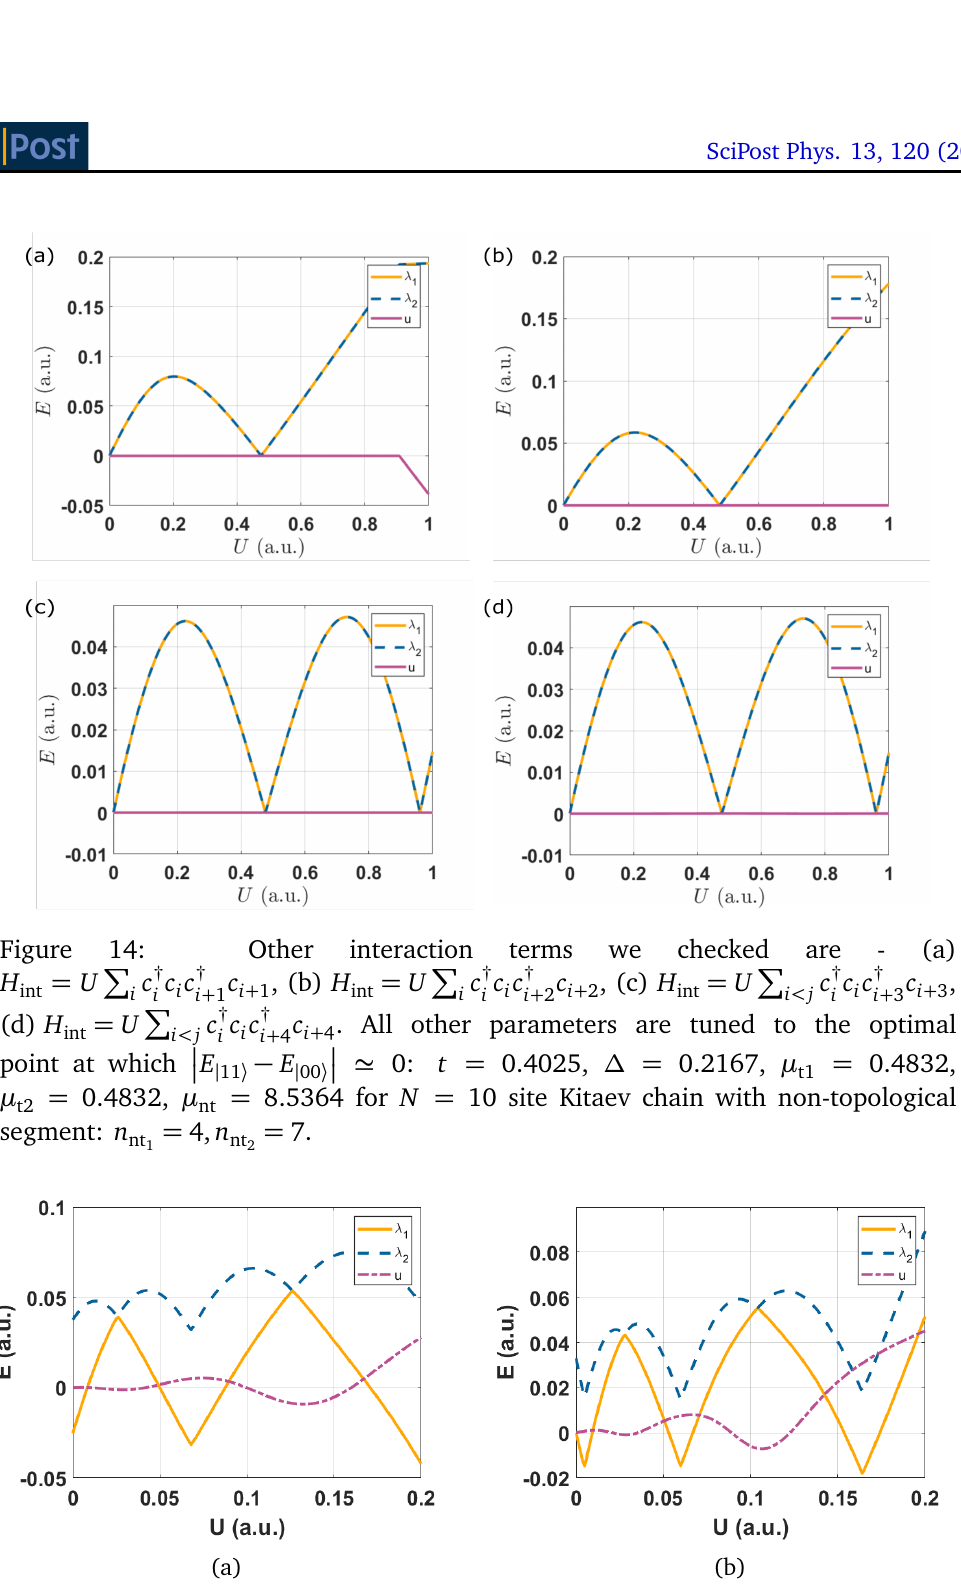
Figure 15: Changing parameters from the optimal point shows that λ (cid:48) s no longer overlap and follow separate trajctories (solid yellow and dashed blue line). Param- eters used in this figure are as follows. (a), N = 10 site Kitaev chain with non- = 4; n = 7; t = 0.4049, ∆ = 0.2207, µ topological segment: n nt 1 nt 2 µ = 0.347, µ = 7.7363. (b), N = 10 fermion Kitaev chain with non-topological t2 nt = 4; n = 7; t = 0.2801, ∆ = 0.1278, µ segment: n nt 1 nt 2 µ = nt